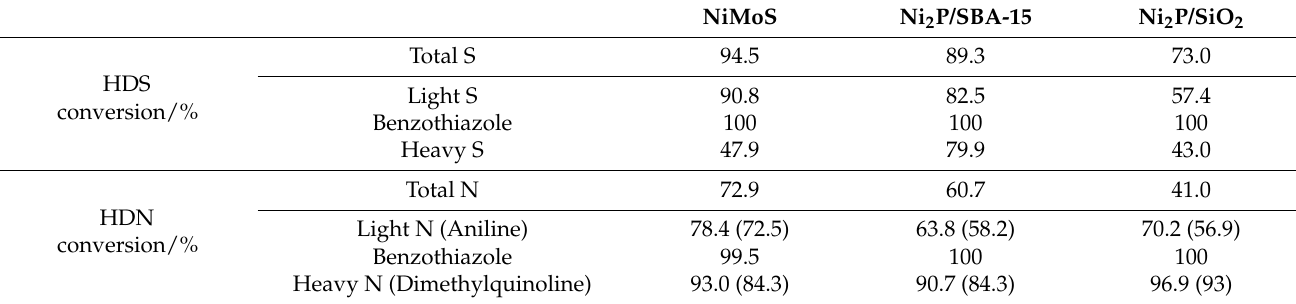
Table 3. Comparison of the reactivity of sulfur and nitrogen-containing